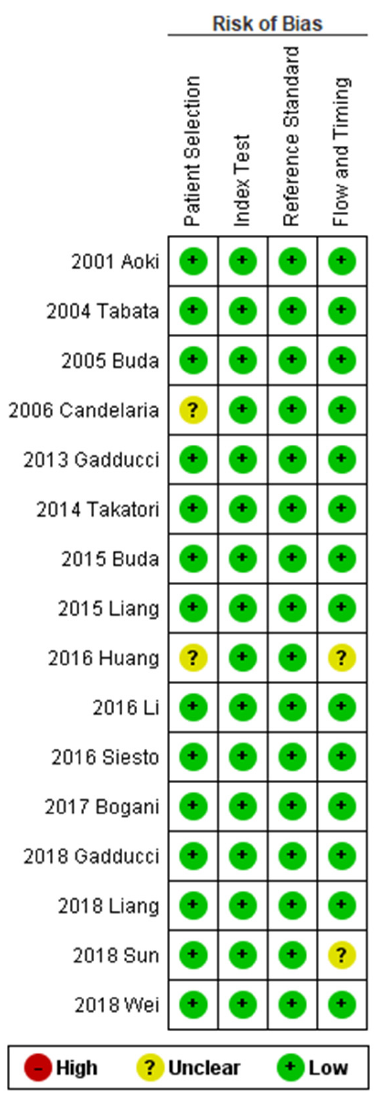
Figure 2. Assessment of risk of bias. Summary of risk of bias for each study; plus sign: low risk of bias; minus sign: high risk of bias; question mark: unclear risk of bias.